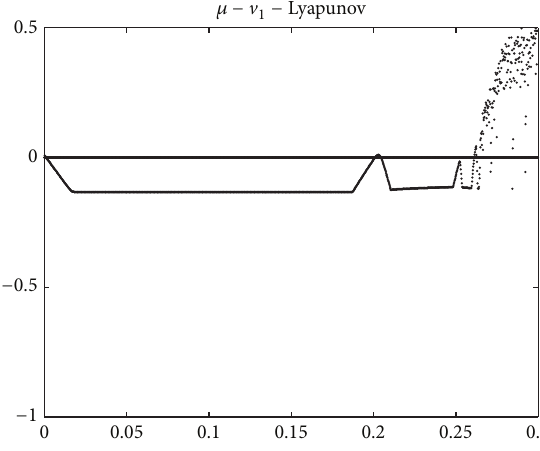
Figure 18: Lyapunov index variations of V 1